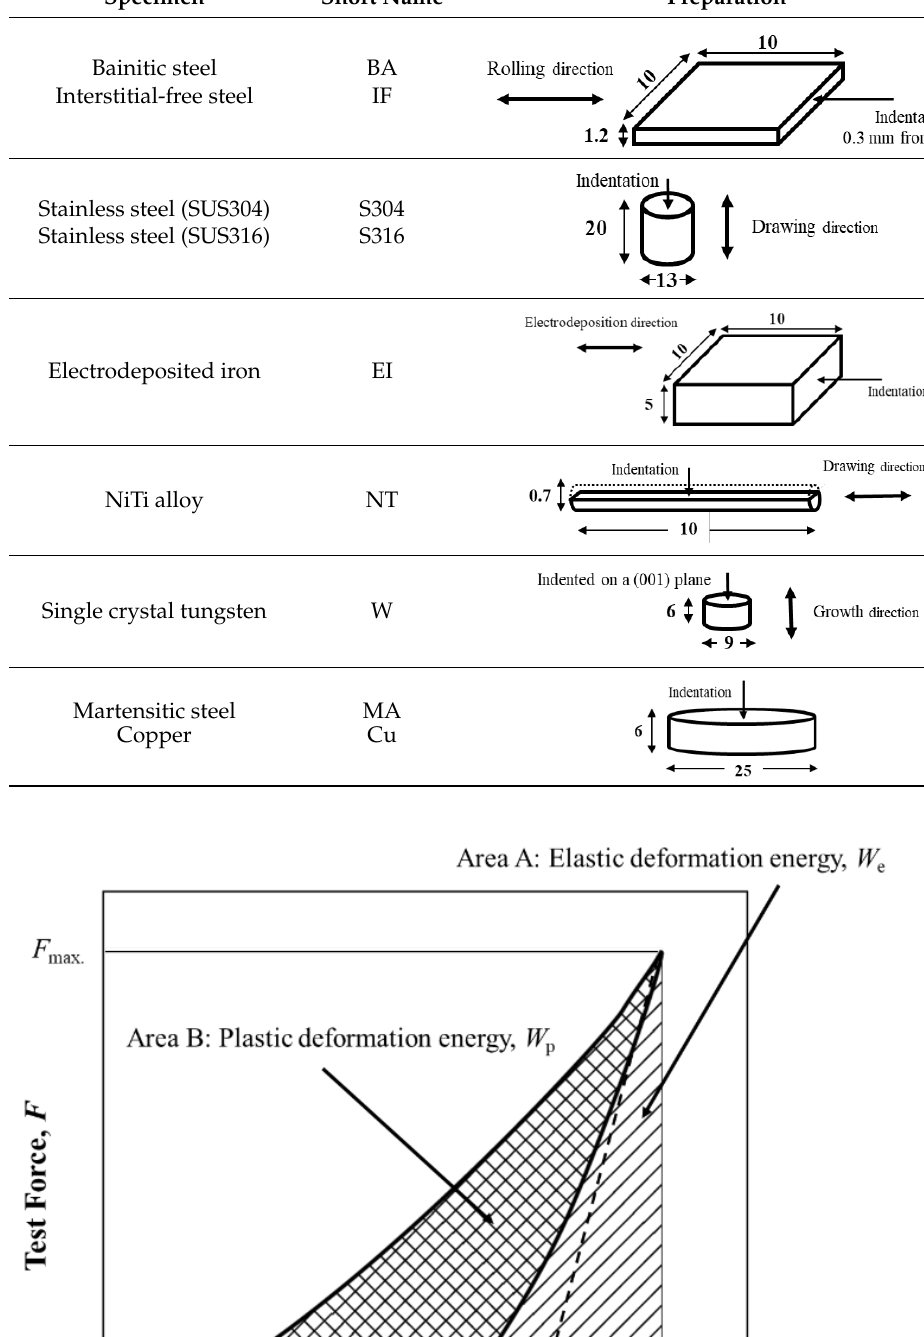
Figure 1. Definition of the elastic and plastic work energies based on load – displacement curves.